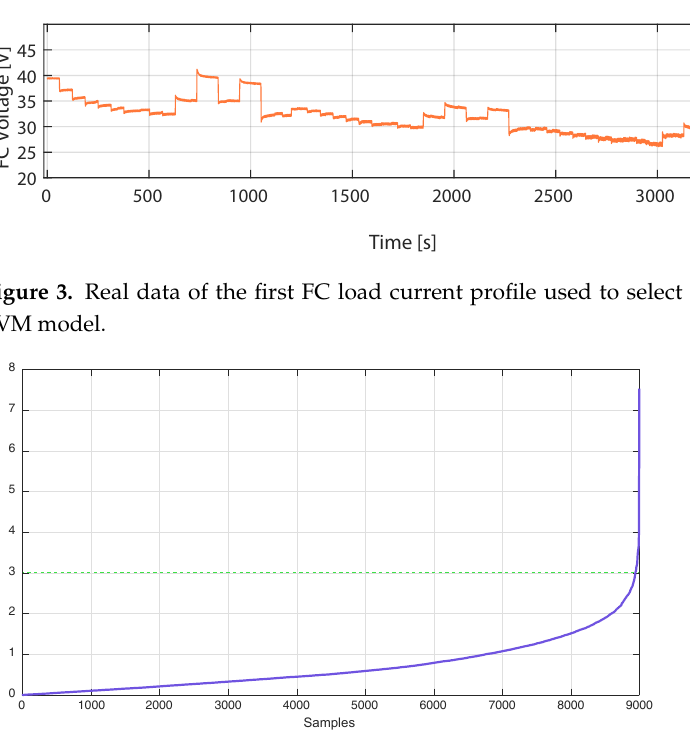
Figure 4. Relative error for each one of the estimated voltage samples used in the training phase of the SVM